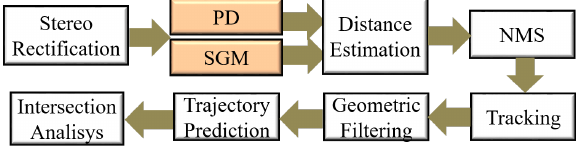
Figure 11. The PCP system general